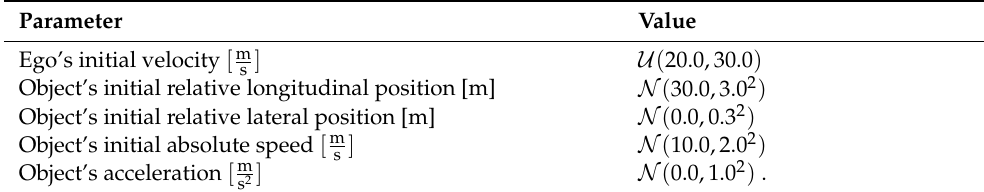
Table A6. Distributions of Scenario A parameters.